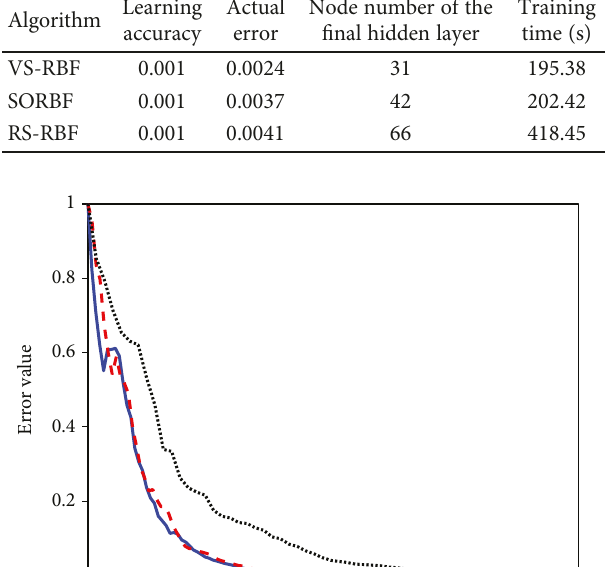
Table 7: Comparisons of average training performance. Learning Algorithm accuracy